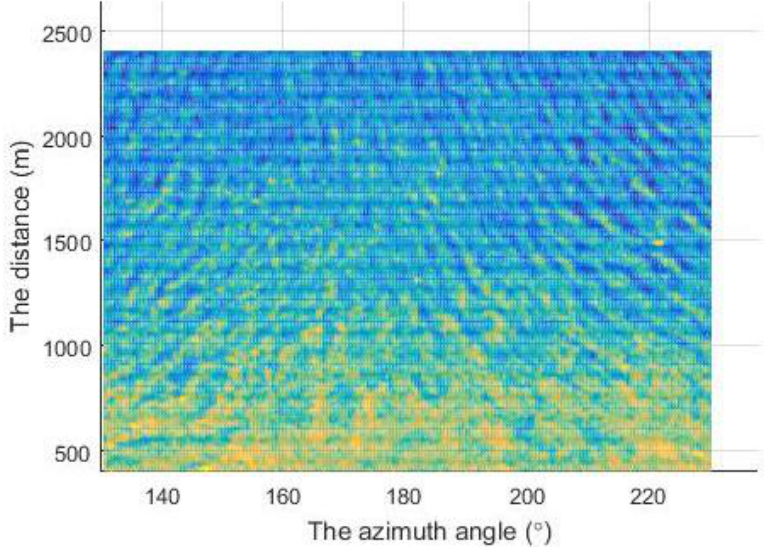
Figure 5. The collected marine radar image in Cartesian coordinates. To further evaluate the influence of surface current on the inversion of wave height, the retrieved significant wave height by using the statistical method from the acquired shore- based radar images on 11–18 November 2014 is presented in Figure 6. The horizontal axis is the time sequence. The vertical axis is the retrieved significant wave height. The green circle denotes the extracted significant wave height by using the traditional shadow statistics method which ignores the influence of the surface current. The extracted significant wave height which considers the influence of the surface current is denoted by the blue triangle. The buoy is placed as an external reference device during the experiment, and the buoy record is indicated by the red cross.